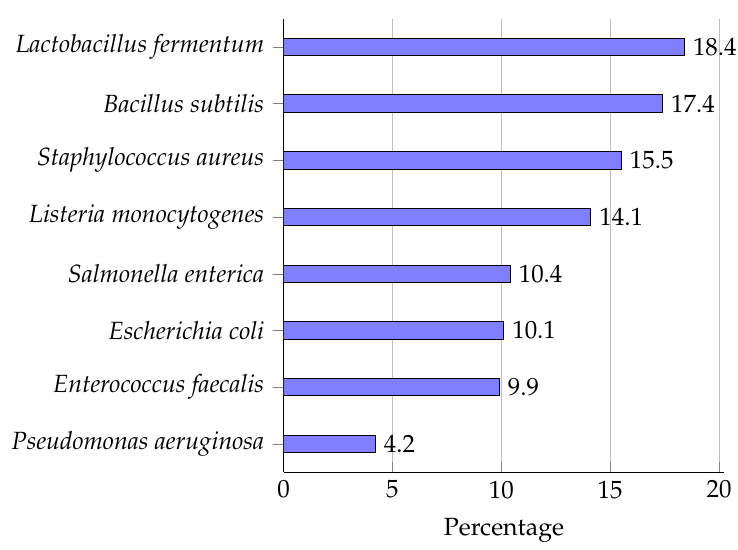
Figure 1. Bacterial composition of the ZymoBIOMICS TM Microbial Community DNA Standard expressed as 16S rRNA gene percentages [45].